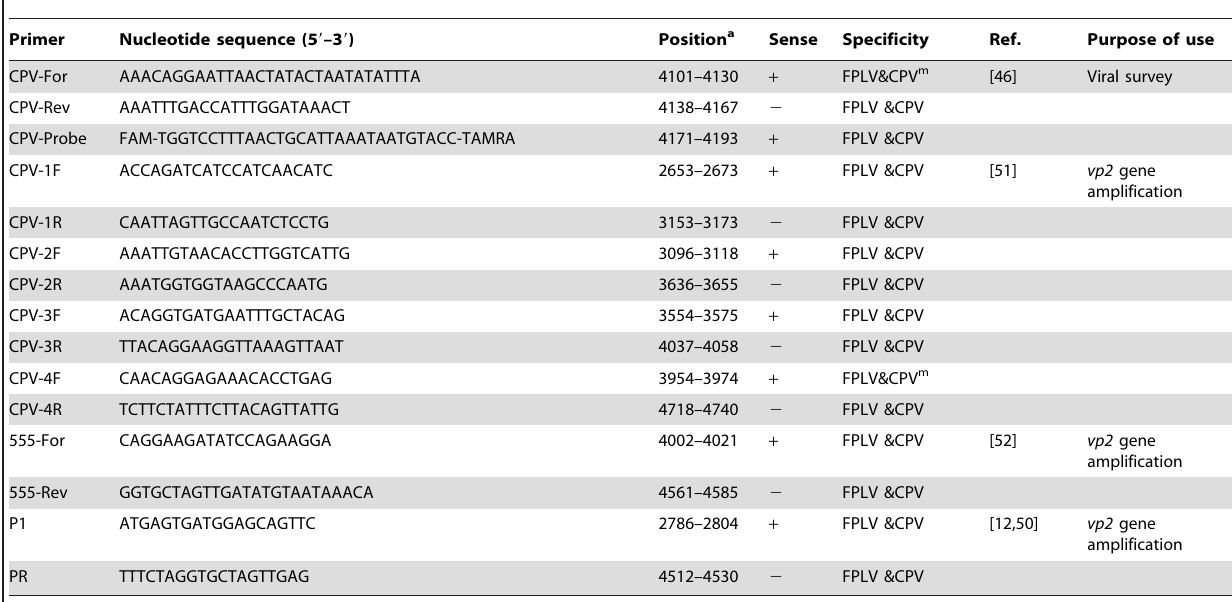
Table 3. Primer sequences and their positions in the genome of parvovirus.